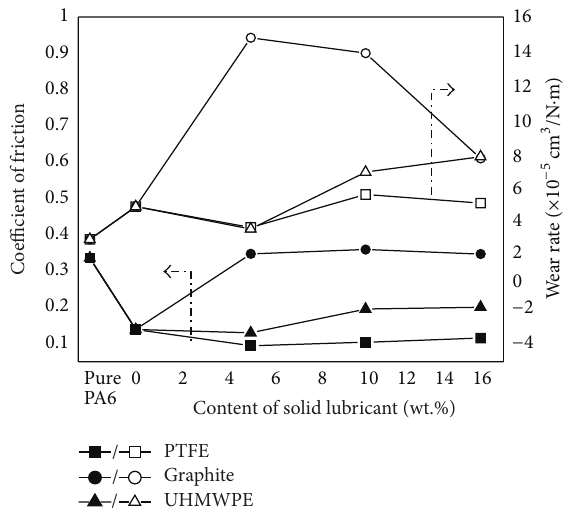
Figure 3: Friction and wear behaviors of PA6/GF composites filled with single solid